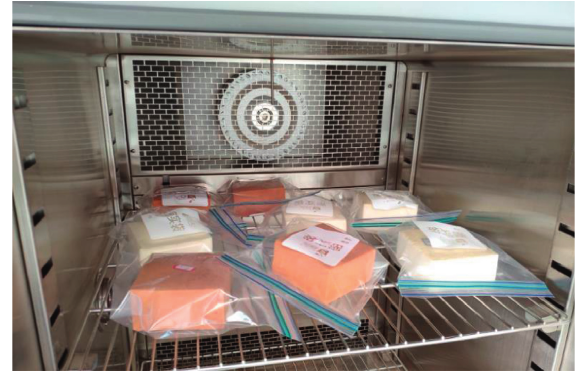
Figure 4: Sample